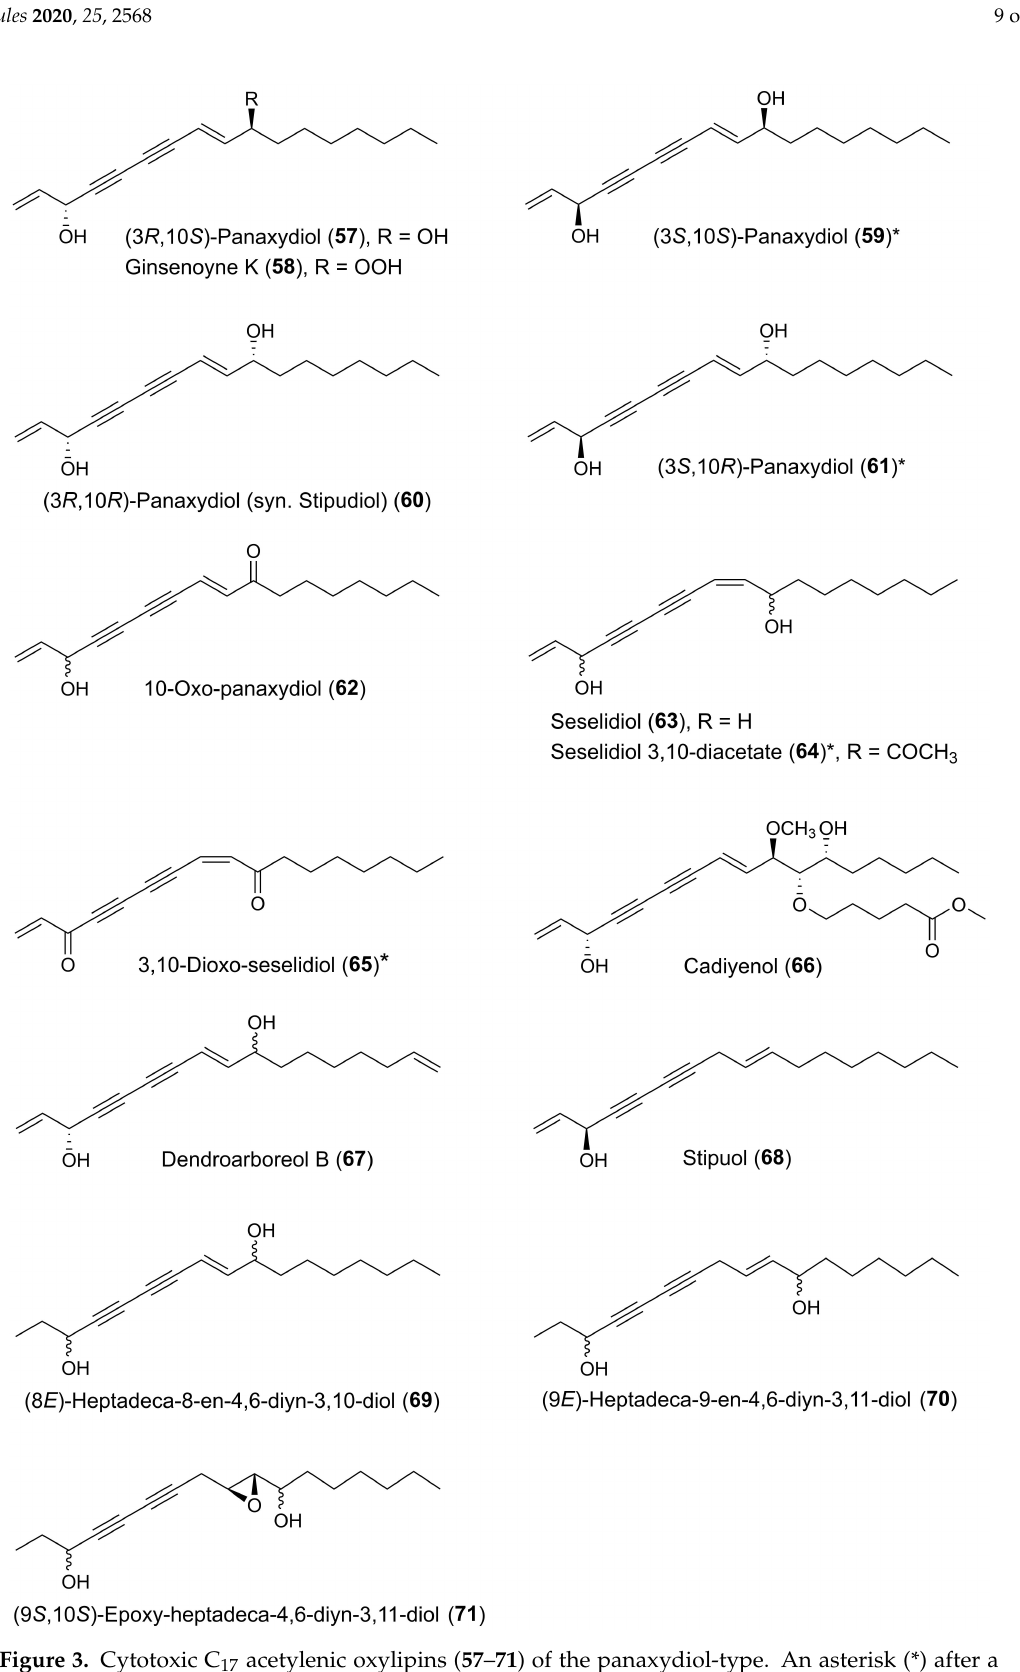
Figure 3. Cytotoxic C 17 acetylenic oxylipins ( 57 – 71 ) of the panaxydiol-type. An asterisk (*) after a compound number, indicates a cytotoxic panaxydiol-type polyacetylene of synthetic origin that is not naturally occurring, but which may prove to be present in